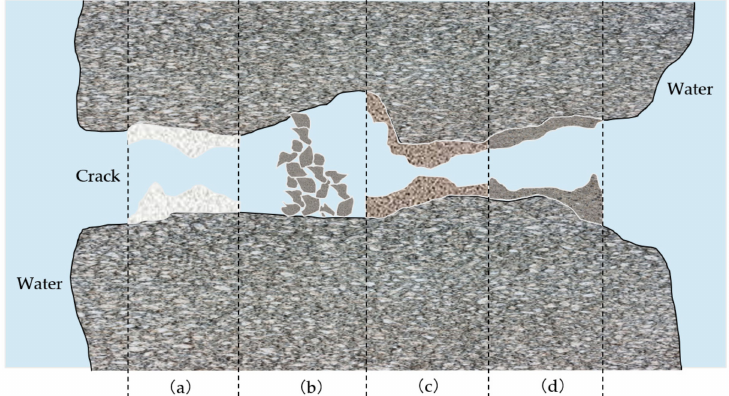
Figure 1. Illustration of the four reactions aiding in self-healing of concrete: ( a ) white precipitation formation; ( b ) loose particles blockage; ( c ) rehydration of unreacted cement particles; ( d ) swelling particles blockage by